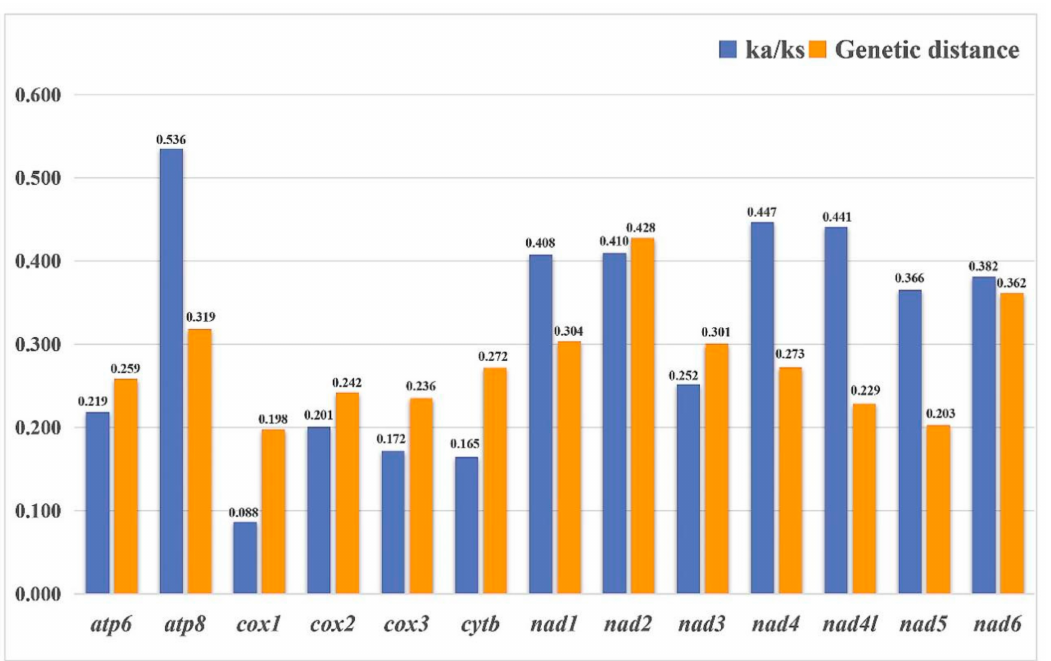
Figure 6. Ka/Ks rates and genetic distance (on average) of 13 PCGs were calculated among eight Ricaniidae species, using Cromna sinensis as a reference